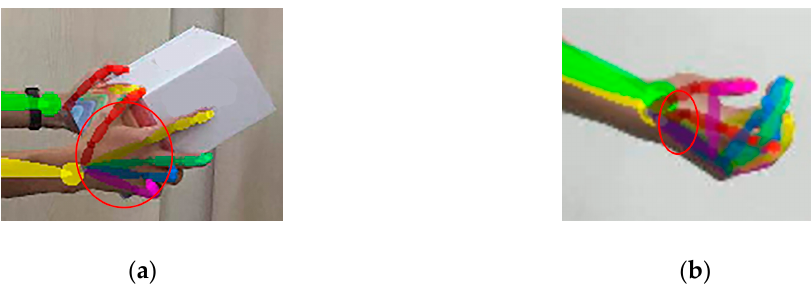
Figure 5. The normal status of the wrist ( a ) and the wrist flip status ( b ).